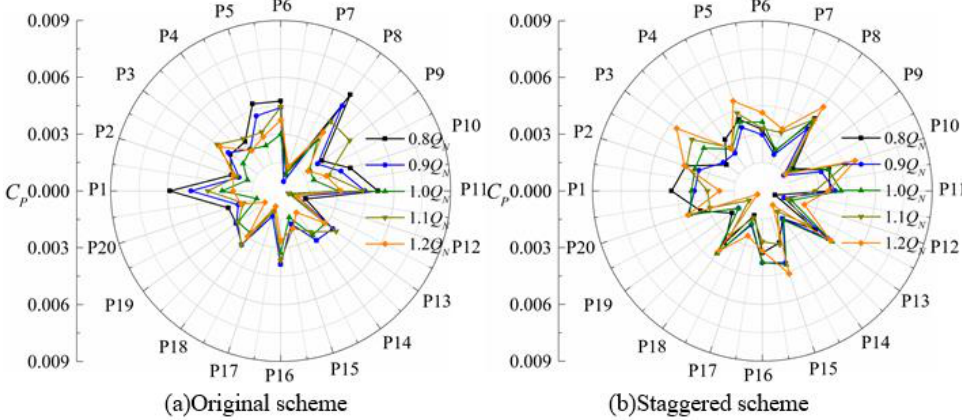
Figure 8. Comparison of 2 f bpf amplitude of pressure pulsation under 0.8 Q N – 1.2 Q N .